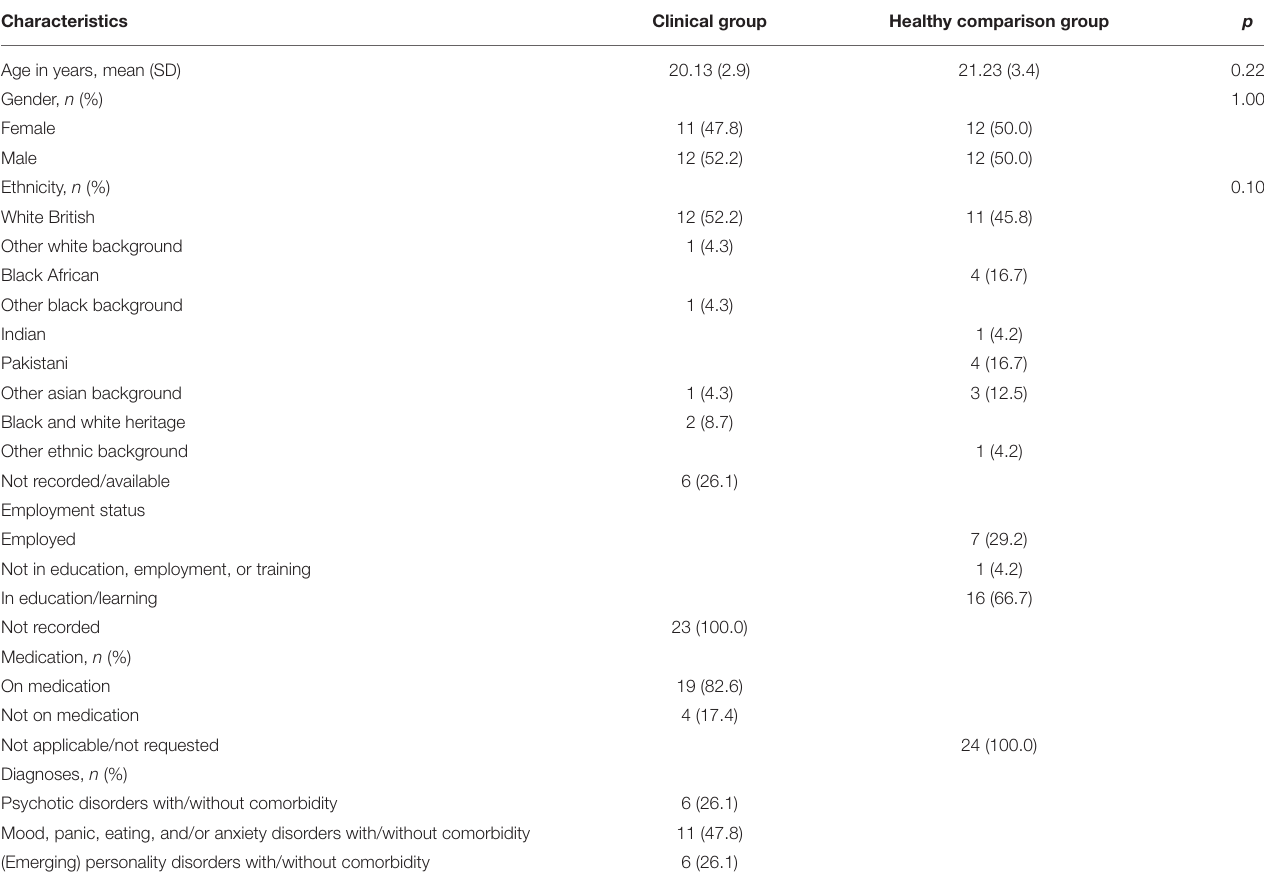
TABLE 2 | Characteristics of the clinical and healthy comparison group. Characteristics Clinical